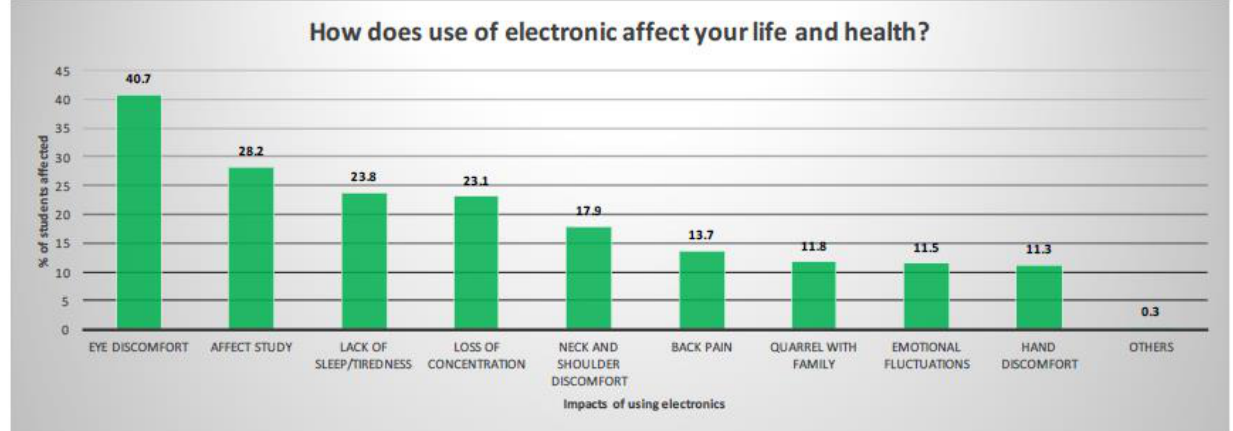
Figure 3. Perception of use of electronic media on health and daily life.